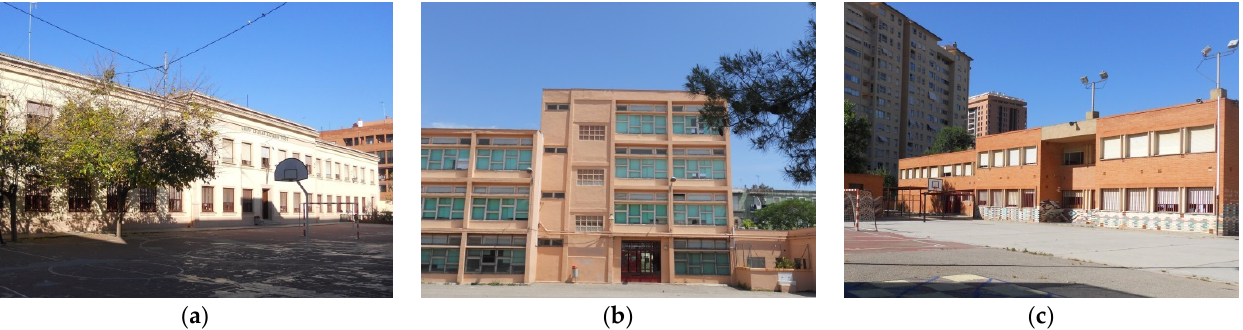
Figure 2. Representative school buildings in the city of Valencia built before 1979. ( a ) Type A school; ( b ) type B school; ( c ) Type C School.